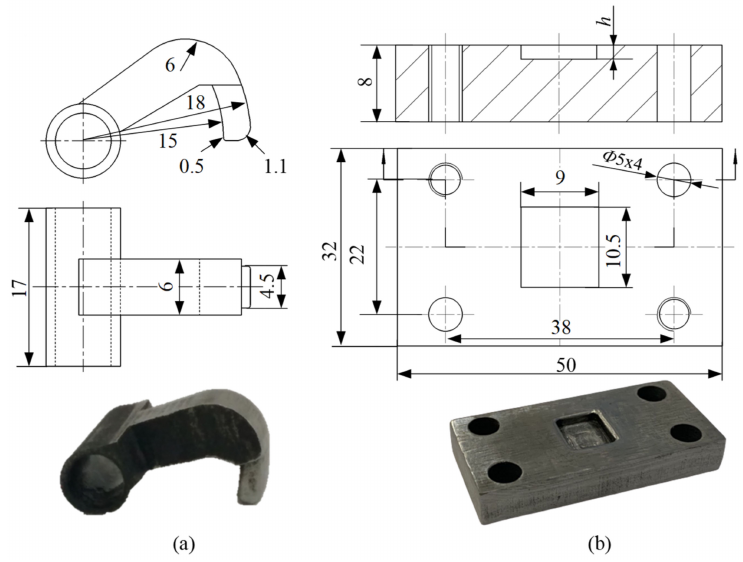
Figure 3. The structure and physical images of the ( a ) rotating punches and ( b ) stationary die (all dimensions in mm).